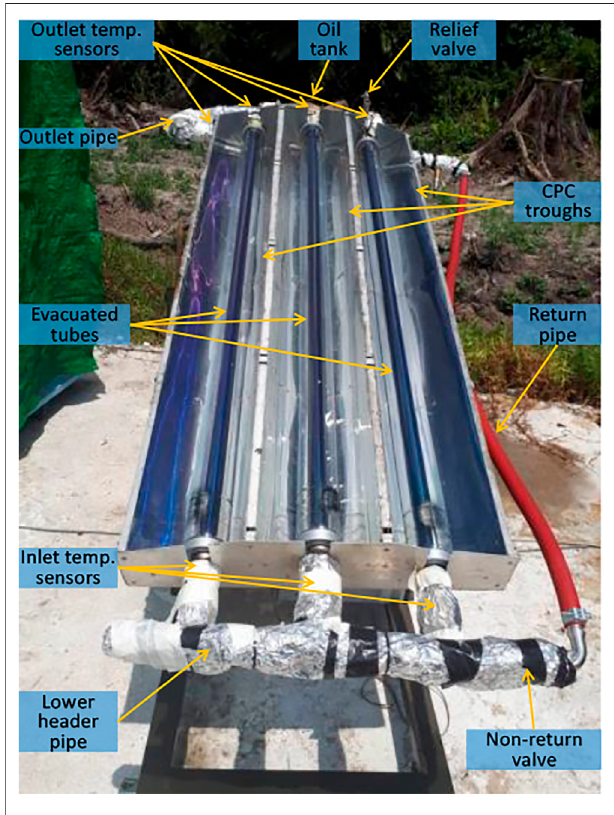
FIGURE 7 | Experimental test rig.